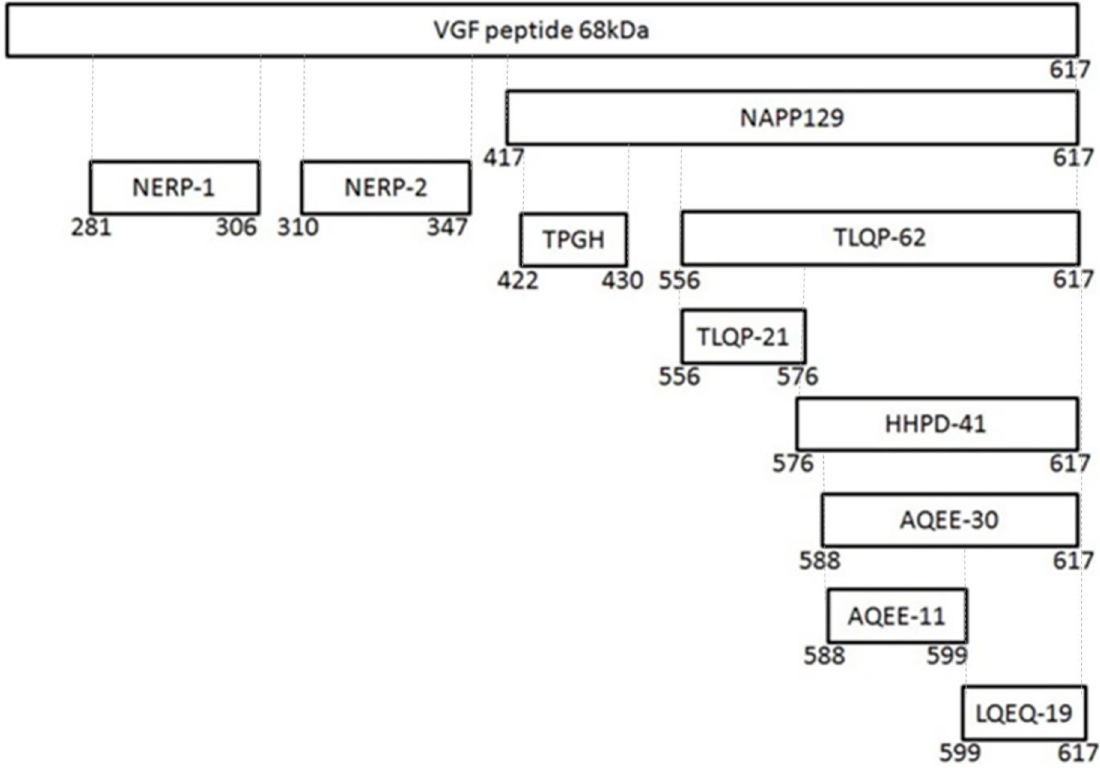
Figure 1. Schematic representation of VGF and of VGF-derived peptides.